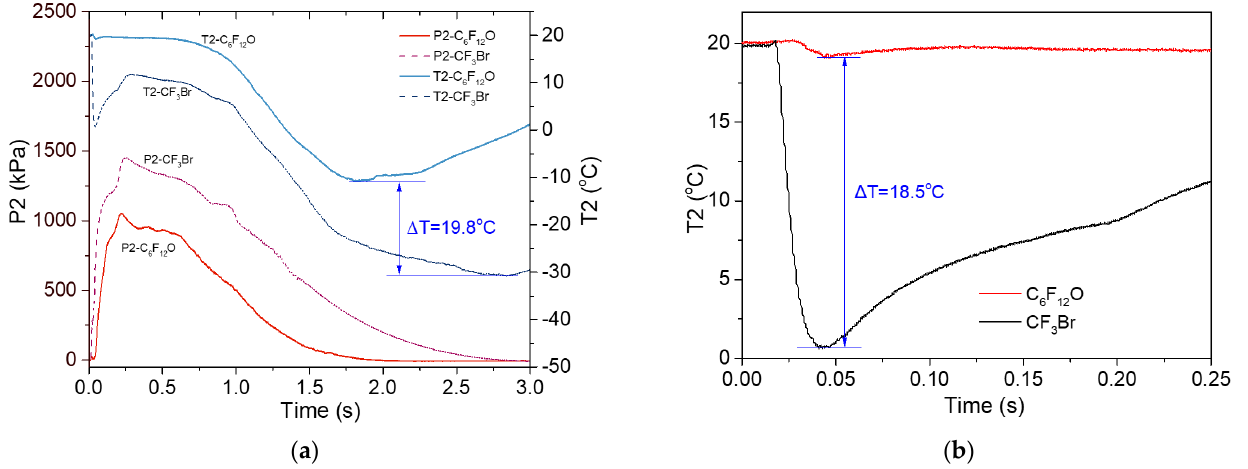
Figure 4. Comparison of the P–T pro fi les of the two tests: ( a ) P2 and T2; ( b )